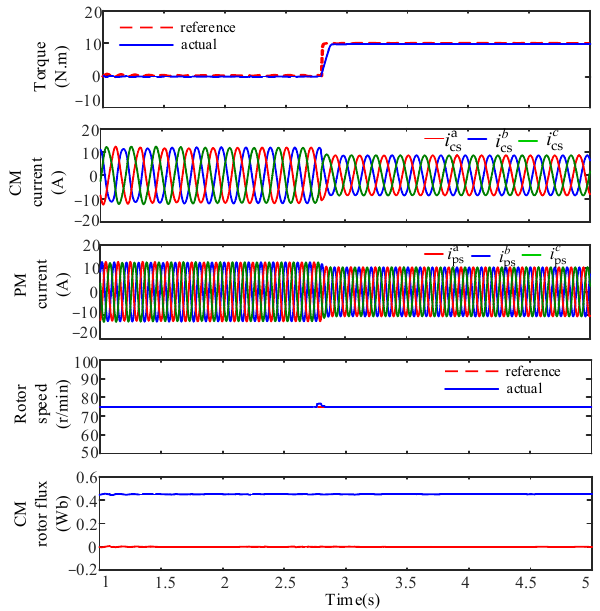
Figure 13. Simulation results when step disturbance is applied. As depicted in Figure 12, the rotor speed changes from 150 r/min to 75 r/min at 2 s, the CM frequency changes from 0 to the negative phase sequence 5 Hz, and the rotor speed responds quickly and is stable at the reference value. When the rotor speed step changes, the CM rotor flux is stable at the reference value. In addition, the system has a stable output torque of − 20 N.m in 2 s~2.12 s; the rotor speed enters the steady state, and the torque is immediately stable at 0 N.m in 2.12 s~2.5 s. The results show that the control strategy is effective. As depicted in Figure 13, the reference speed of 75 r/min is kept constant, at which point the CM power supply frequency is the negative phase sequence 5 Hz. When 10 N.m load torque is added at 2.8 s, the torque response is fast, and the reference value is tracked accurately. With the increase in load torque, the CM and PM stator current decrease.